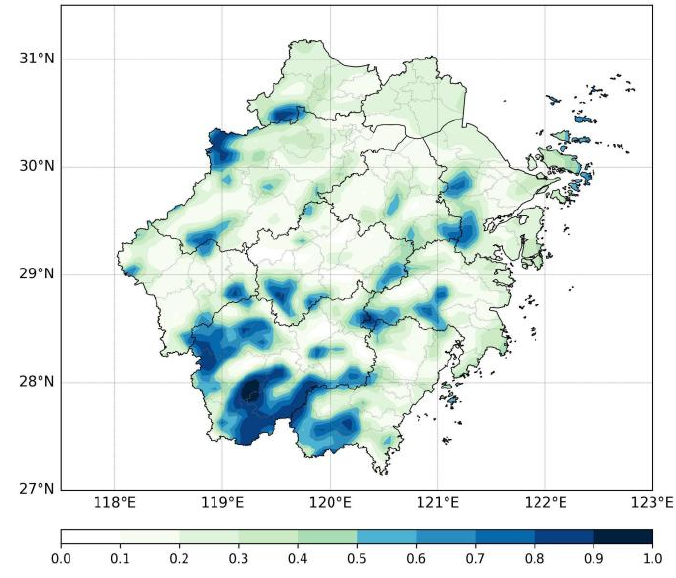
Figure 2. Distribution of CDI in Zhejiang Province.